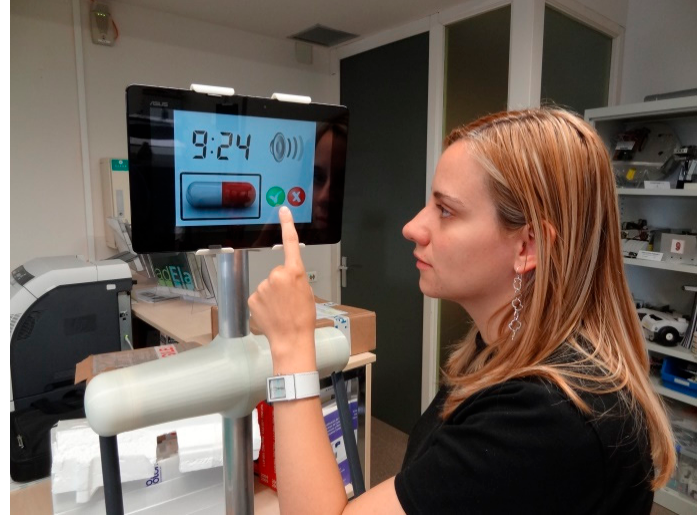
Figure 17. Simulation of the APR providing a daily or regular routine notification.